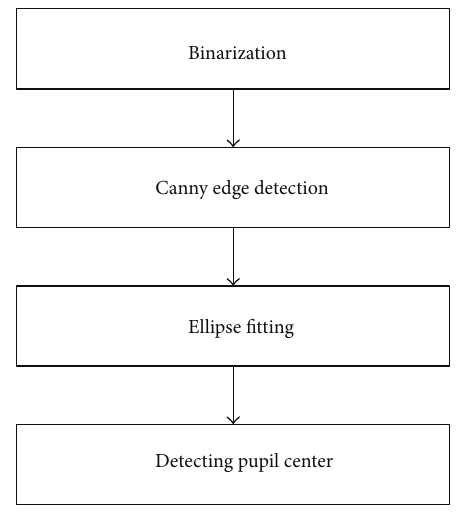
Figure 7: Flowchart for the accurate detection of pupil